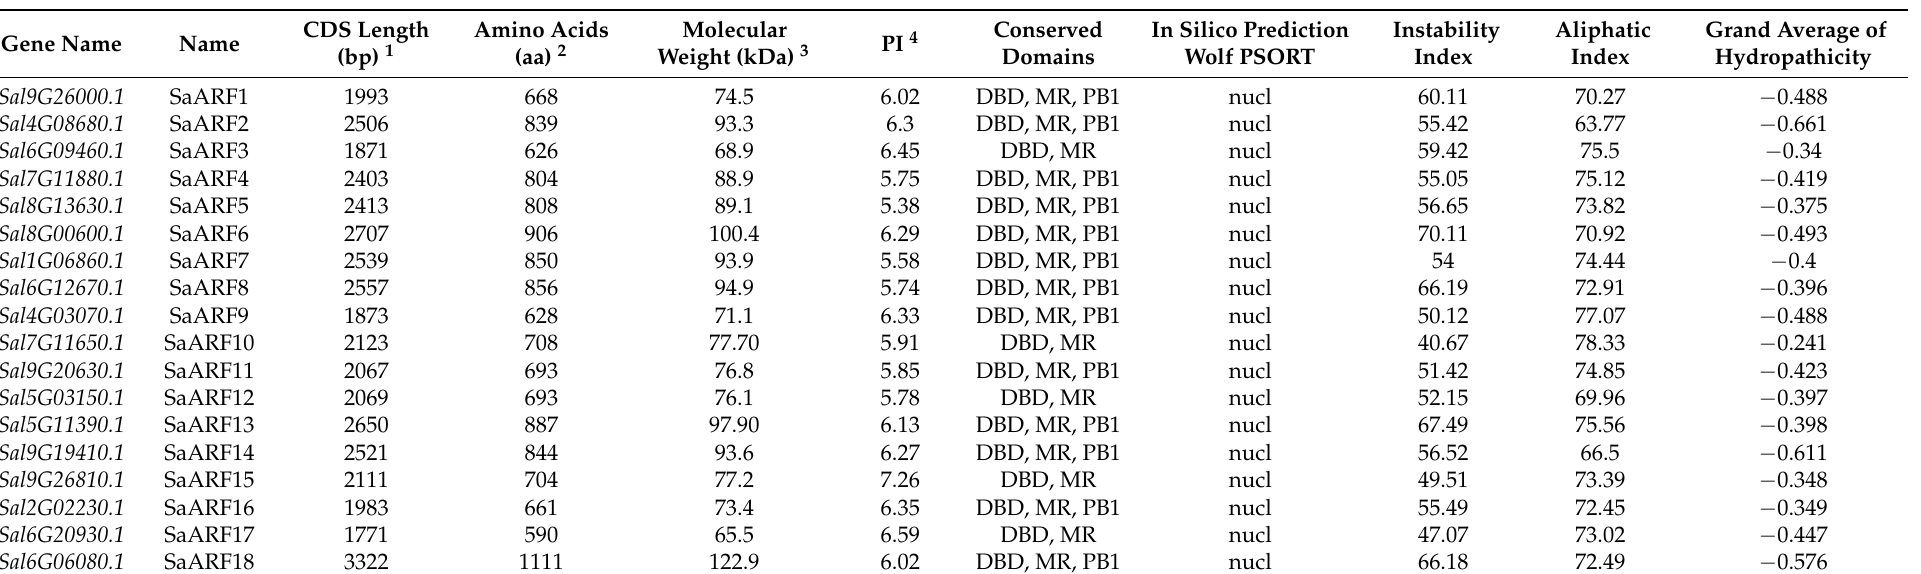
Table 1. Characteristics of putative genes encoding auxin response factors in Santalum album